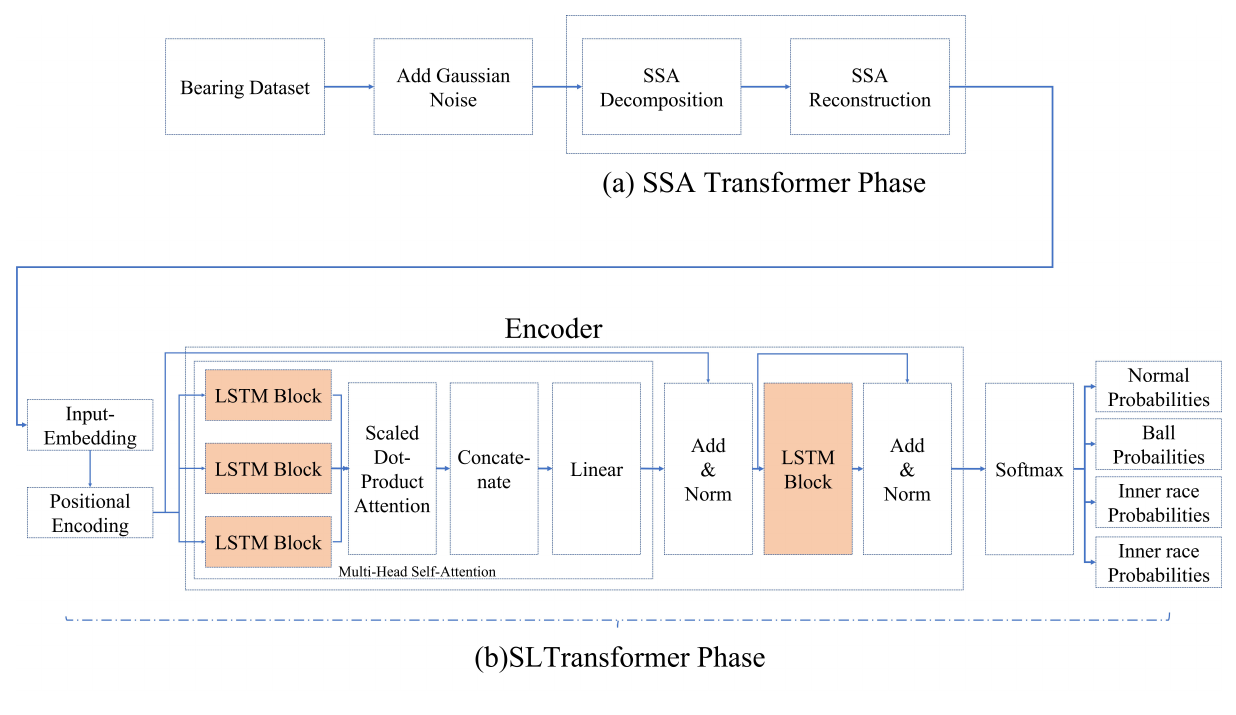
Figure 3. The framework of SSA-Sl